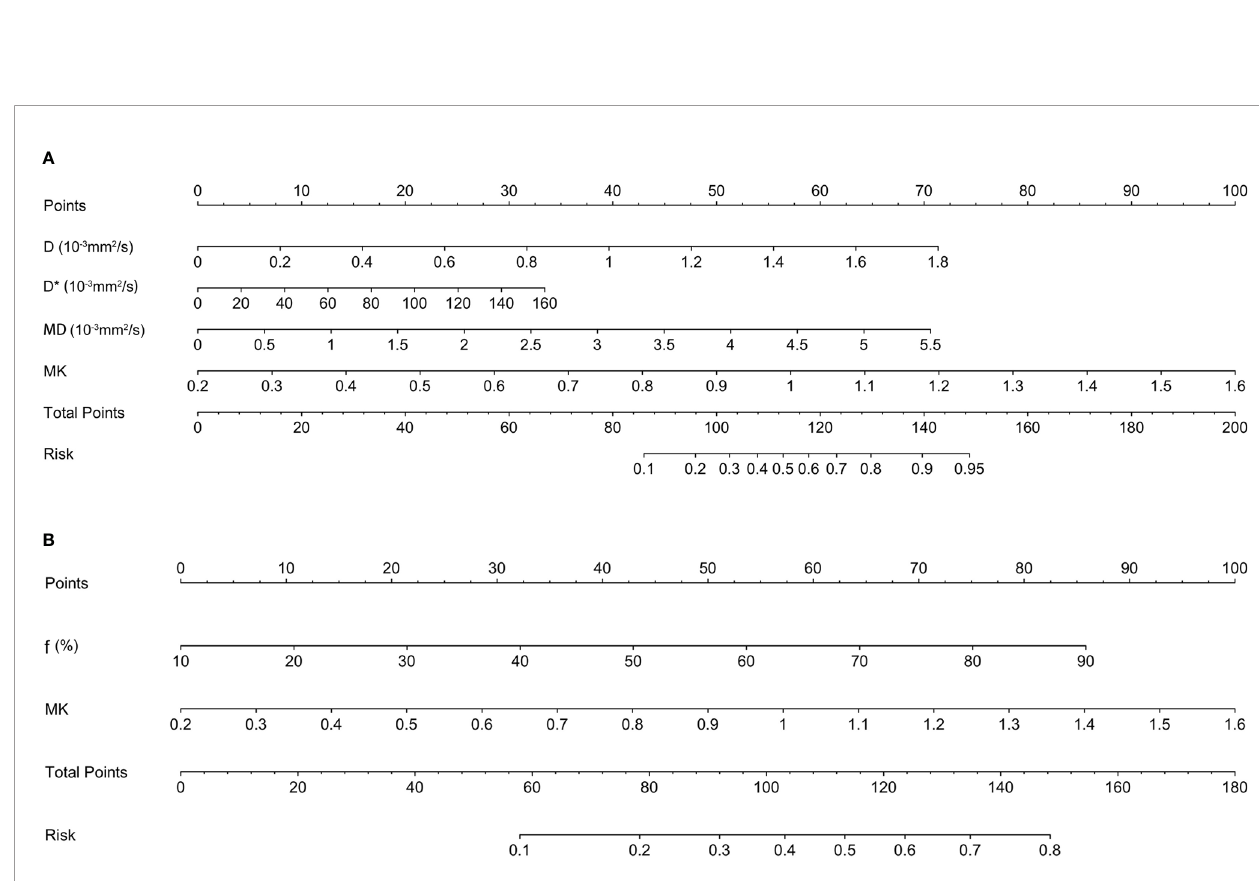
FIGURE 5 | ROC analysis of IVIM and DKI parameters in predicting Luminal subtypes (A) and triple-negative subtype of breast cancer (B) . ROC, receiver operating characteristic; IVIM, intravoxel incoherent motion; DKI, diffusion kurtosis imaging.